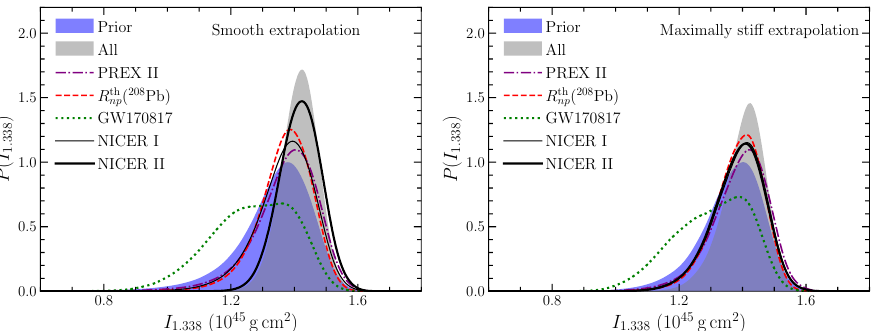
Figure 6. The Λ 1.4 probability densities (priors, individual posteriors, and combined posteriors) from the smooth high-density extrapolation ( left ) and the maximally-stiff high-density extrapolation ( right ) energy density functionals.